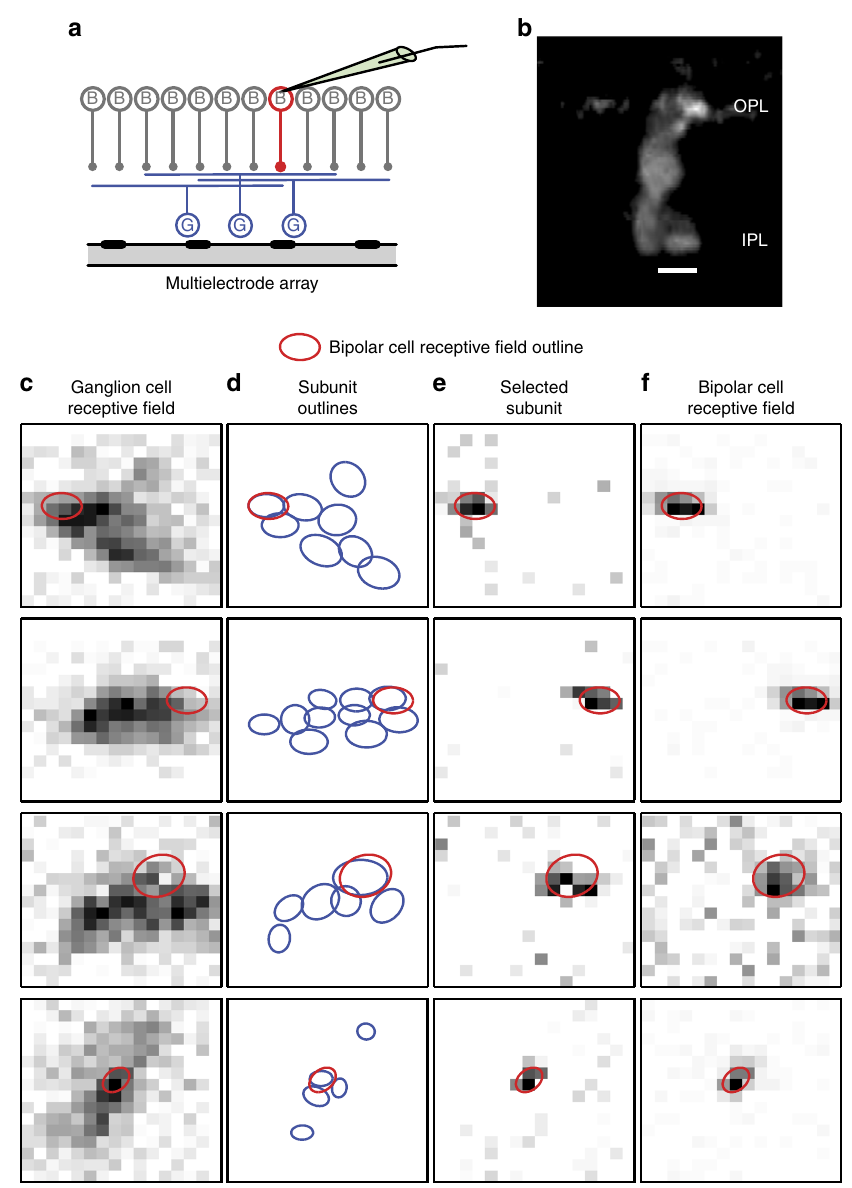
Fig. 3 Comparison of ganglion cell subunits and simultaneously recorded bipolar cell receptive fi elds. a Illustration of the experiment ( left ), where one bipolar cell (B, red ) is recorded with a sharp microelectrode, while multiple ganglion cells (G, blue ) are simultaneously recorded with a multielectrode array. b Sample staining of a bipolar cell that was imaged after the combined intracellular and multielectrode-array recording, displaying neurites both in the outer plexiform layer (OPL) and inner plexiform layer (IPL). Scale bar, 10 µ m. c Pixel-by-pixel representation of ganglion cell receptive fi elds, obtained as the spatial component of the spike-triggered average under spatiotemporal white noise. The red ellipse here and in subsequent panels shows the receptive fi eld outline of the simultaneously recorded bipolar cell. d Outlines of identi fi ed subunits ( blue ellipses ). e Pixel-by-pixel representation of the best matching identi fi ed subunit. f Pixel-by-pixel representation of the bipolar cell receptive fi eld, obtained as the spatial component from the corresponding reverse correlation analysis. Scale bar, 100 µ